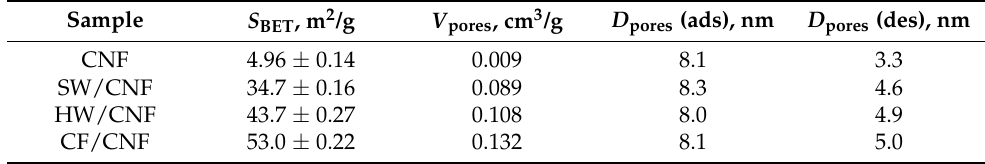
Figure 9. ( a ) Nitrogen adsorption–desorption isotherms and pore-size distribution curves calculated using the Barret– Joyner–Halenda (BJH) method for the ( b ) adsorption and ( c ) desorption branches of the isotherms. Table 2. Textural characteristics of materials.